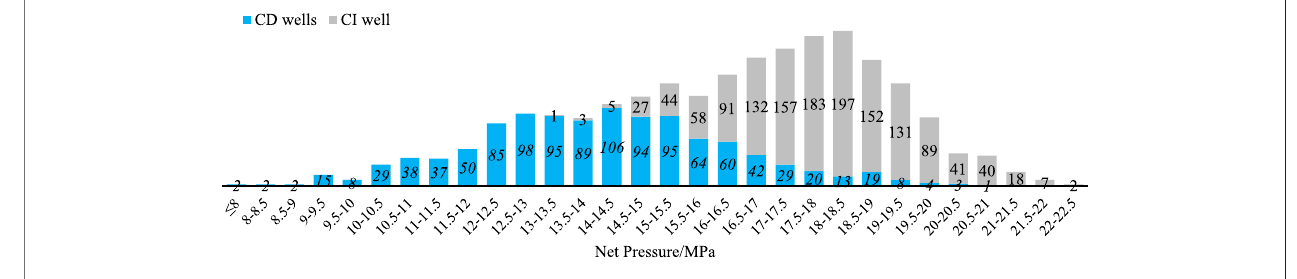
FIGURE 1 | Distribution of the number of stages at different real-time net pressures in the whole area.